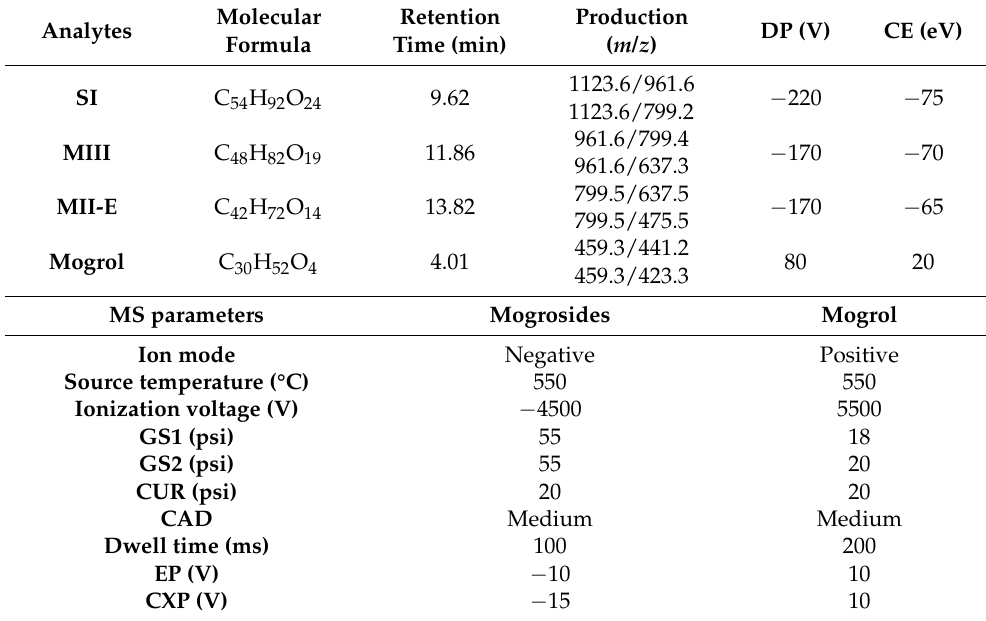
Table 1. HPLC-MS/MS